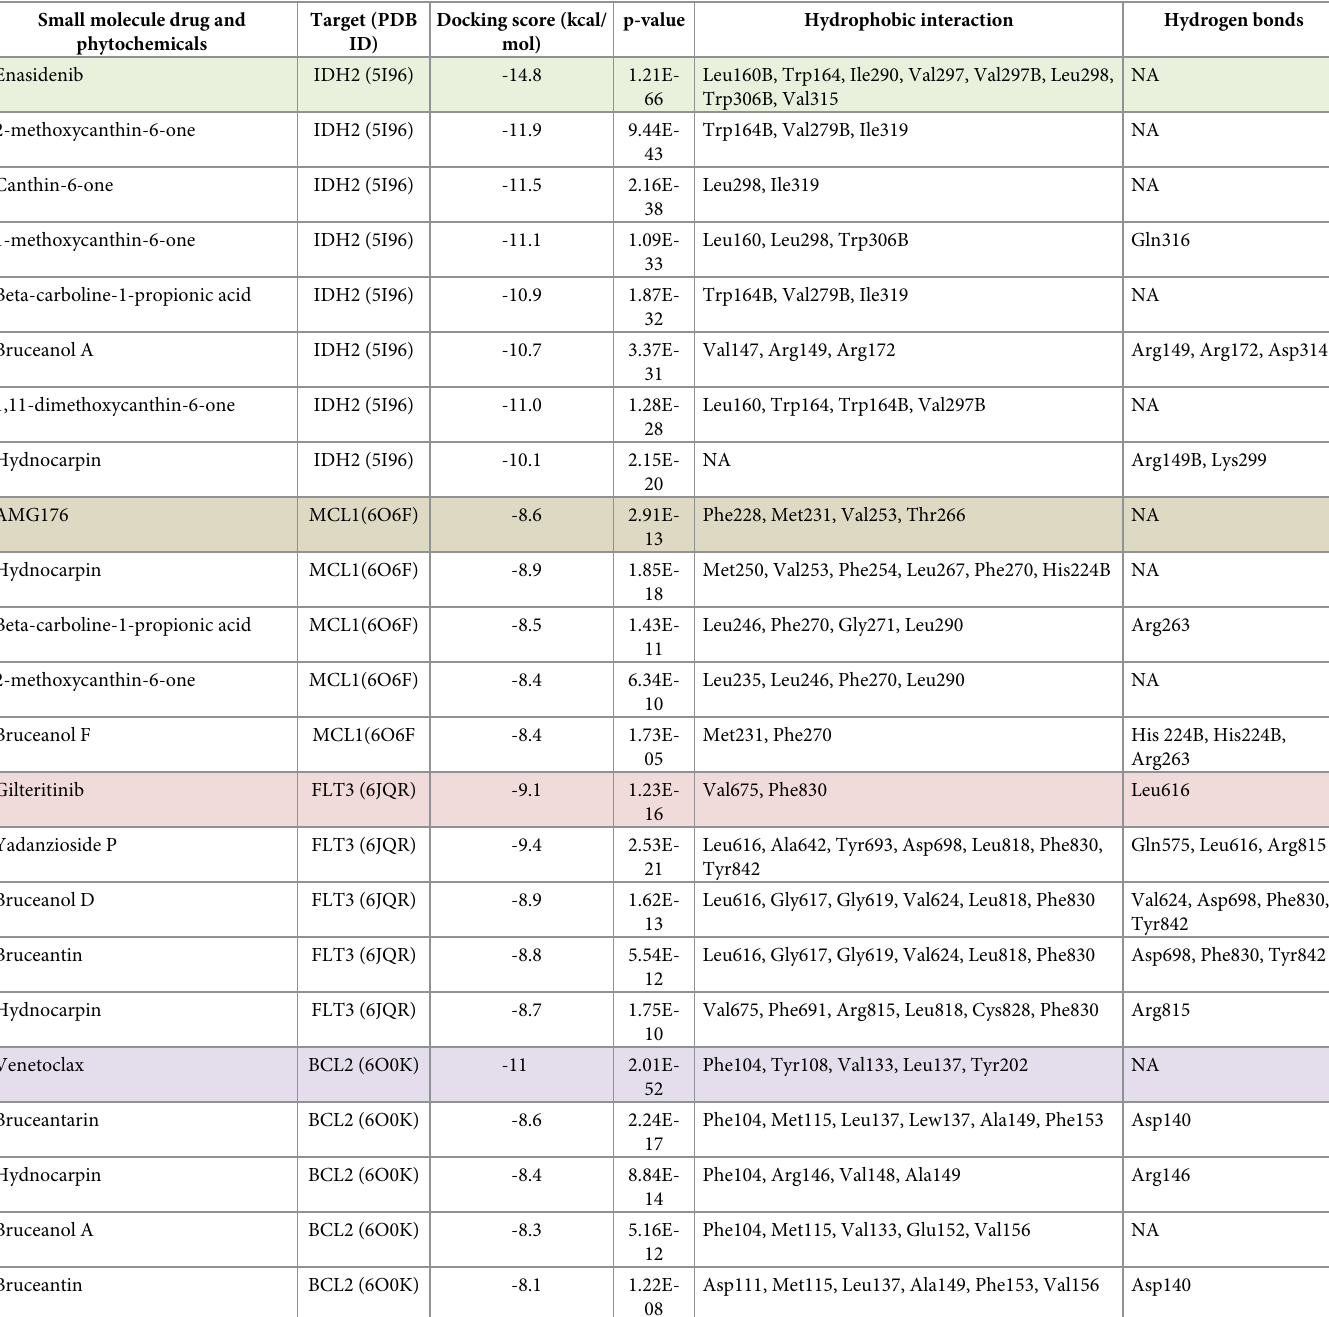
Table 1. Binding affinity energies, nature of interaction and interacting amino acid residues between the compounds (small molecule drug and phytochemicals) and AML receptors. Small molecule drug and